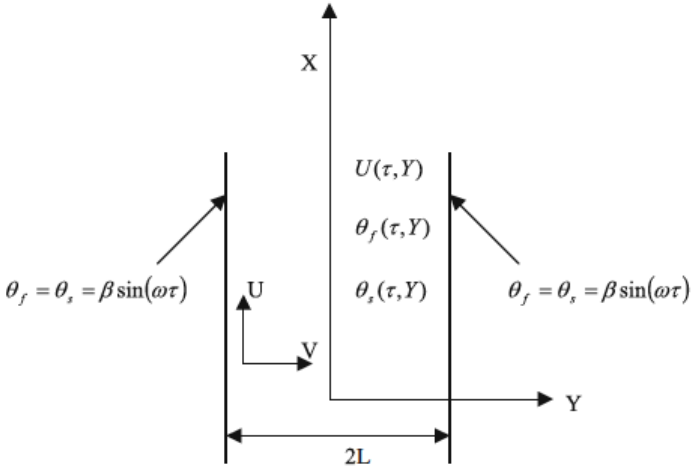
Figure 33. The physical problem studied by Khadrawi et al.